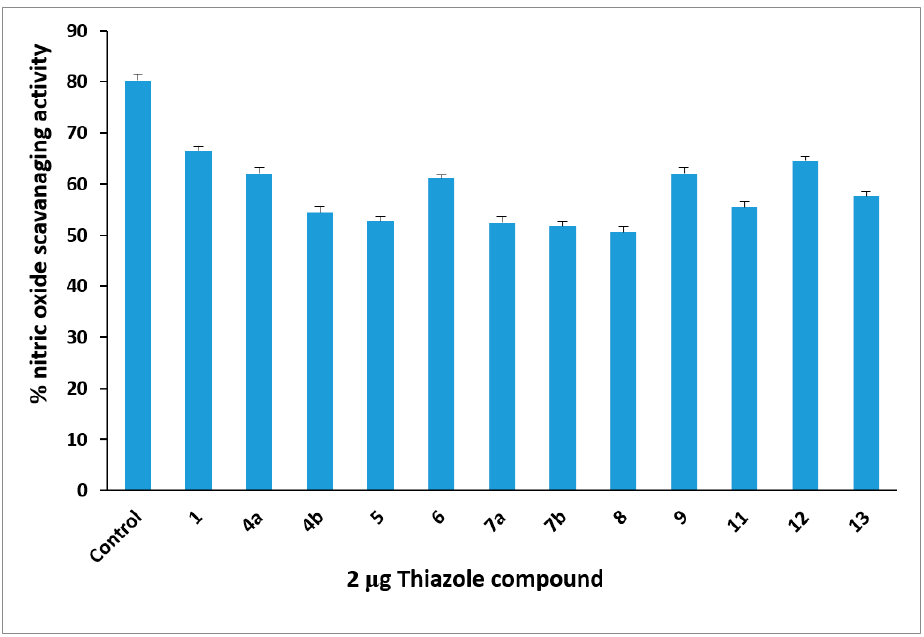
Figure 2. The nitric oxide scavenging activity of the tested compounds.